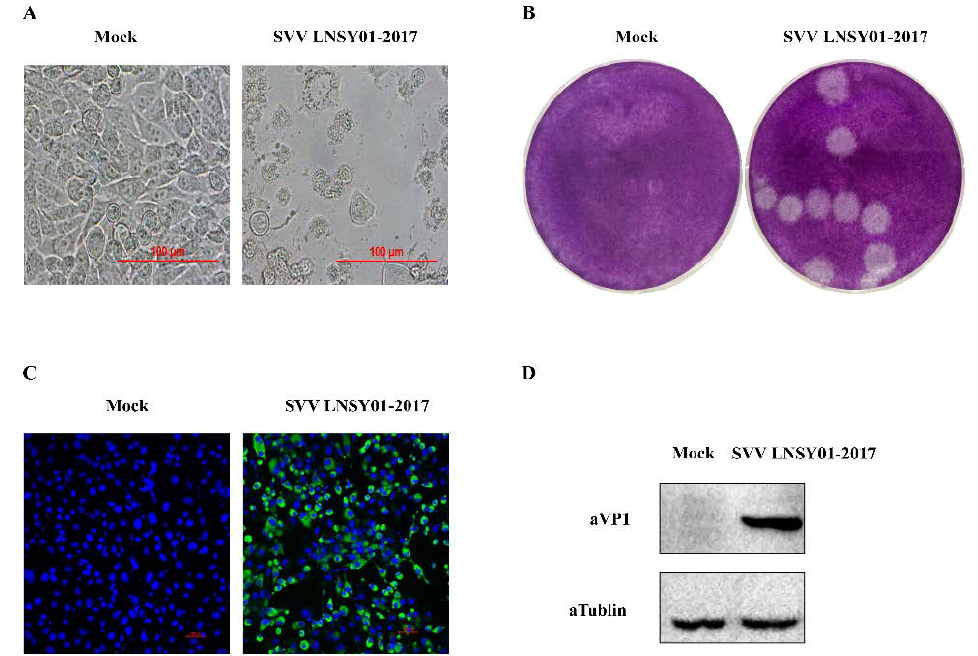
Figure 1. Characteristics of SVV LNSYO1-2017. ( A ) The cytopathic effect of BHK-21 cells infected with SVV LNSYO1-2017 strain at 24 h post-infection. ( B ) Plaque morphology in BHK-21 cells infected with third-passage of SVV LNSYO1-2017 strain at 48 h post-infection. ( C ) Immunofluorescence assay (IFA) of BHK-21 cells infected with SVV LNSYO1-2017 strain at 18 h post-infection. Cells were stained with primary antibody using homemade rabbit anti-SVV VP1 polyclonal antibody. ( D ) Western blotting analyses of BHK-21 cells infected with SVV LNSYO1-2017 strain at 18 h post-infection. Cells were stained with primary antibody using a homemade rabbit polyclonal anti-SVV VP1 antibody and mouse anti-tubulin antibody.